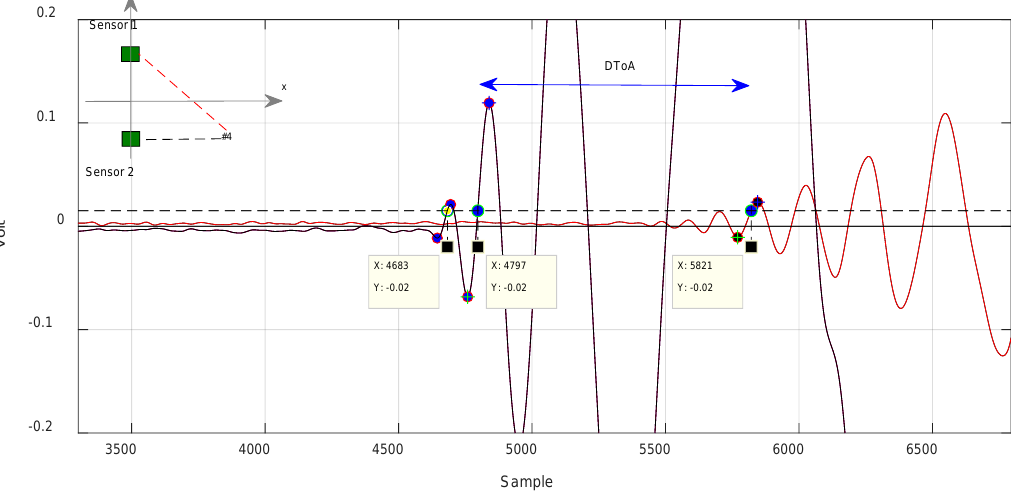
Figure 13. Impact case in position #4, signal received from the sensors sensor 1 and sensor 2. Evaluation method of the DToA with algorithm. Ts = 1 × 10 −7 s.